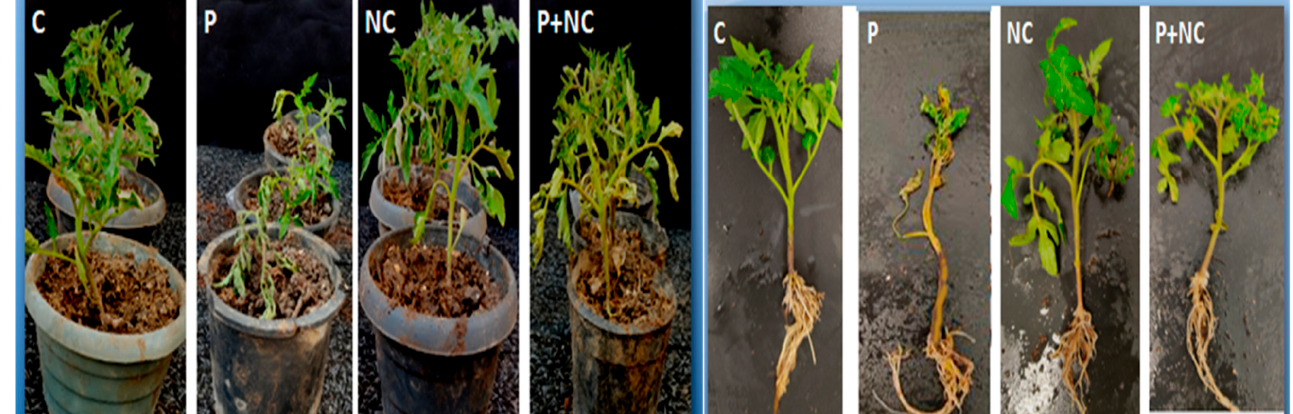
Figure 2. Physical appearance of plant after treatments. Left; Tomato ( Solanum lycopersicum ) plant after 14 days treatments in pot experiment, Right;plant morphology at the end of pot experiments after 30 days. Note: C for control, NC = plants treated with nano-fertilizer with Ag/CHI NC, P = plants treated with R. solani , (P + NC) = pots inoculated with R. solani and Ag/CHI NC solution (50 mL) twice a day for three days.